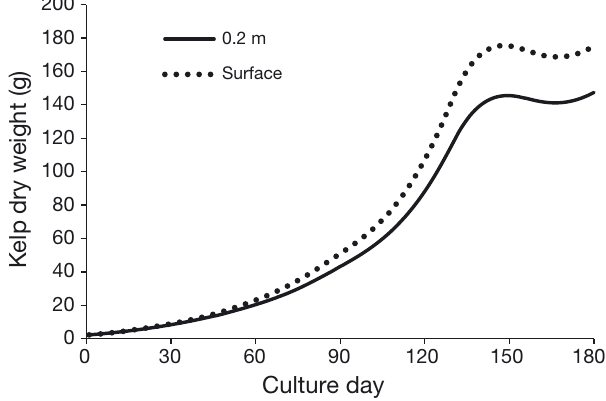
Fig. 9. Simulated growth (individual dry weight) of kelp Sac- charina japonica when lifting the culture ropes from 0.2 m depth to the